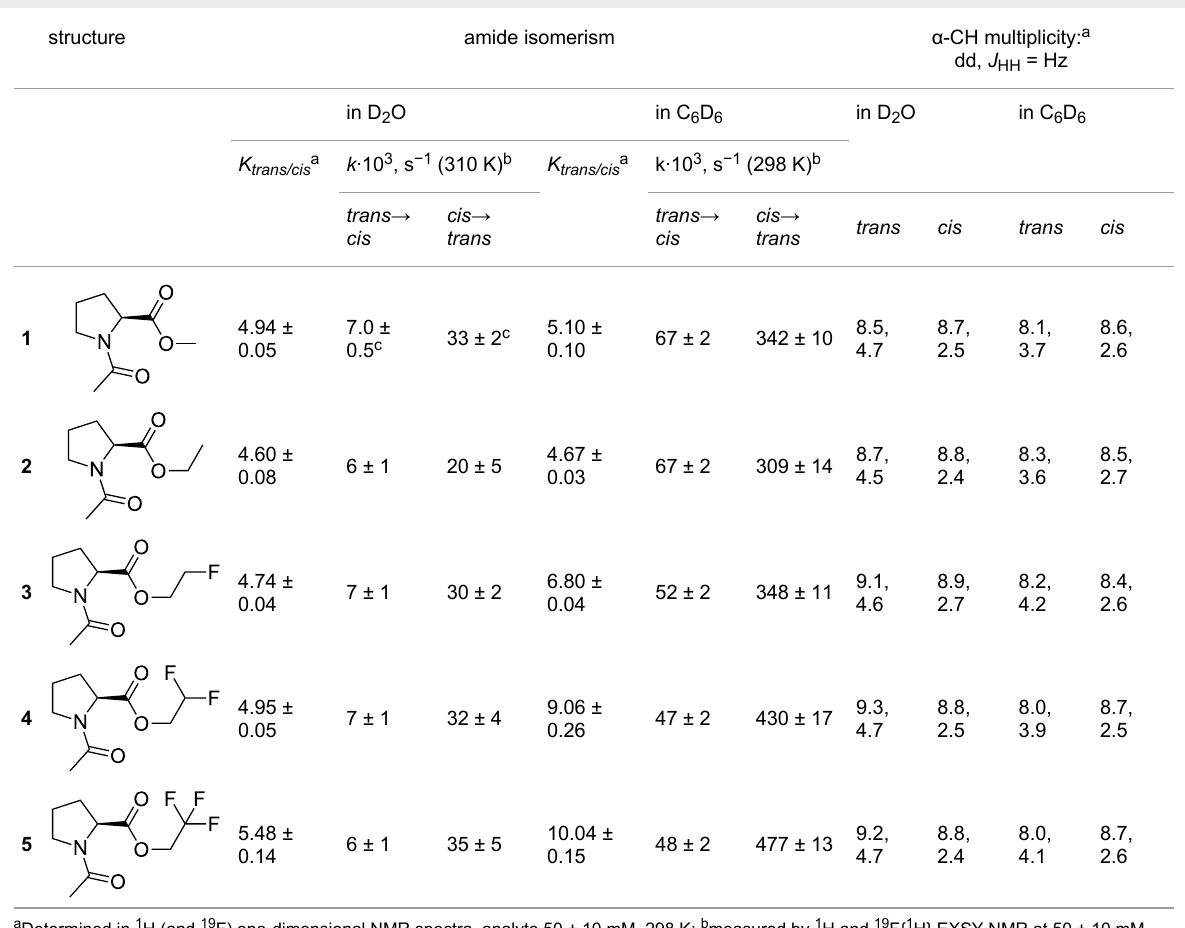
Table 2: Summarized conformational properties of the compounds 1 – 5 as measured by NMR.